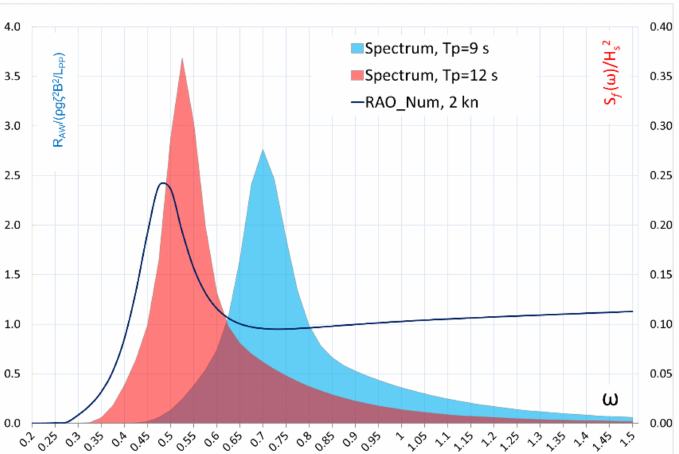
Figure 3. The added resistance in regular head waves together with two